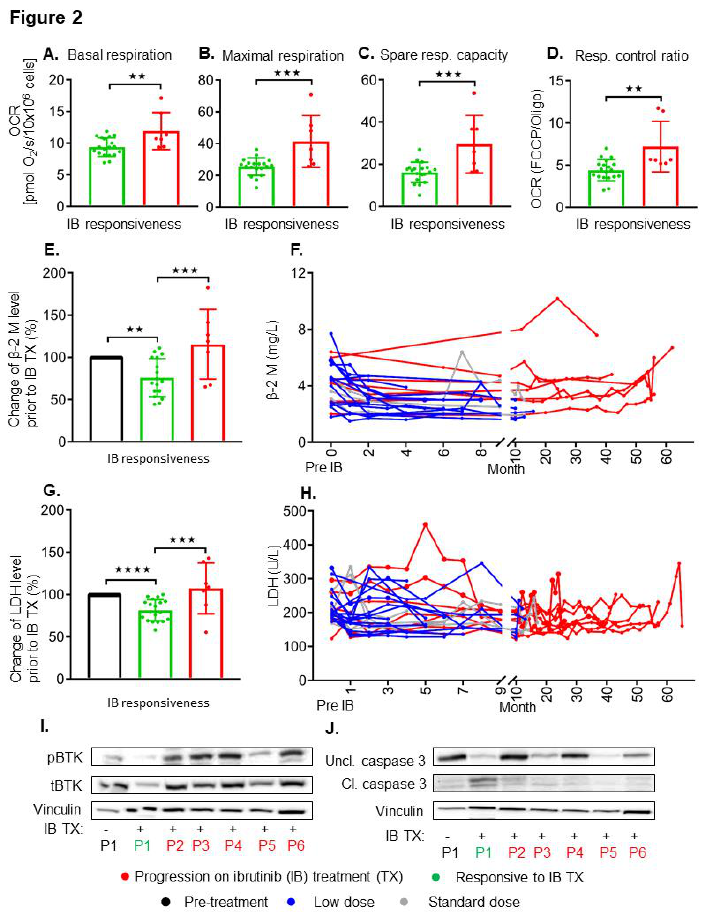
Figure 2. Patients progressed while on ibrutinib treatment have increased mitochondrial respiration profiles, β -2 M, LDH, and loss of BCR signaling suppression and caspase-3 cleavage. Basal respiration ( A ), maximal respiration ( B ), spare respiratory capacity ( C ), and respiratory control ratio ( D ) are summarized in freshly isolated CLL cells from ibrutinib-sensitive (green) and patients who have progressed on ibrutinib (red). Values are mean ± S.D., ibrutinib- sensitive, N = 19, and ibrutinib- progressed, N = 7. ** p < 0.005, *** p < 0.0005 (unpaired two-tailed Student’s t -test). Plasma levels of β -2 M ( E ) and LDH ( G ) are summarized from pre-treatment (black), ibrutinib-sensitive (green) and progressed on ibrutinib treated patients (red). Values are mean ± S.D., ibrutinib-sensitive, N = 19, and ibrutinib-progressed, N = 7, pre-treatment, N = 26. ** p < 0.005, *** p < 0.0005, **** p < 0.0001 (one way ANOVA with Tukey’s post hoc test). Time-dependent effects of ibrutinib treated samples are shown on β -2 M ( F ) and LDH ( H ) level with low (blue), standard (grey) dose, and with progression on ibrutinib treatment (red). Western blot analysis demonstrating the effect of ibrutinib on pBTK, tBTK ( I ) and caspase-3 cleavage ( J ) in progressed samples ( H ). Protein levels of pBTK/tBTK ratios and cleaved/uncleaved caspase-3 ratios in ibrutinib-sensitive (P1 in green) and ibrutinib-progressed (P2-P6 in red) compared to pre-treatment sample (P1 in